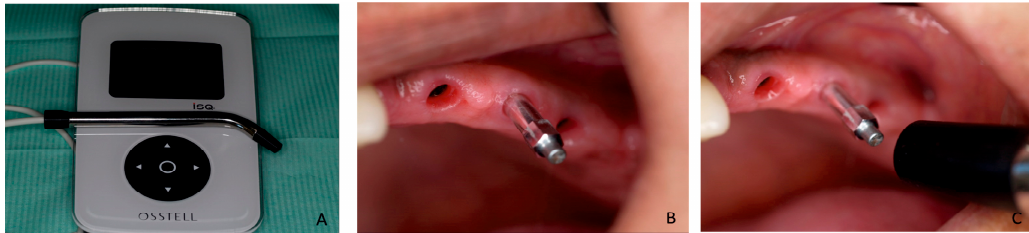
Figure 8. ( A ) Implant-bone contact rigidity was measured by RFA (Osstell™ Mentor, Integration Diagnostic AB, Sweden). RFA measurements were obtained before the healing cape was screwed into